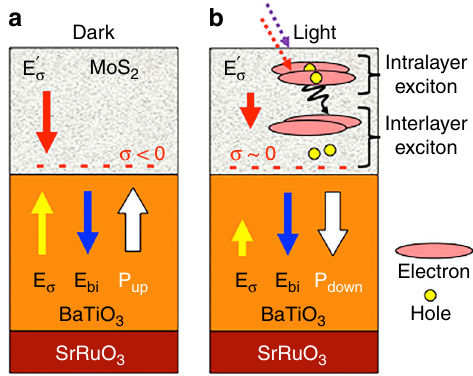
Fig. 4 Mechanism of the photo-induced switching. a Illustration of the electric fi elds E σ and E ′ σ in BTO and MoS 2 , respectively, a built-in electric fi eld E σ accumulated at the interface when BTO bi and the negative charge is switched to the P up state. b Generation of the polar excitons under optical illumination resulting in compensation of the interfacial charge σ , decrease of the associated fi eld E σ , and polarization reversal to the P down state favored by E